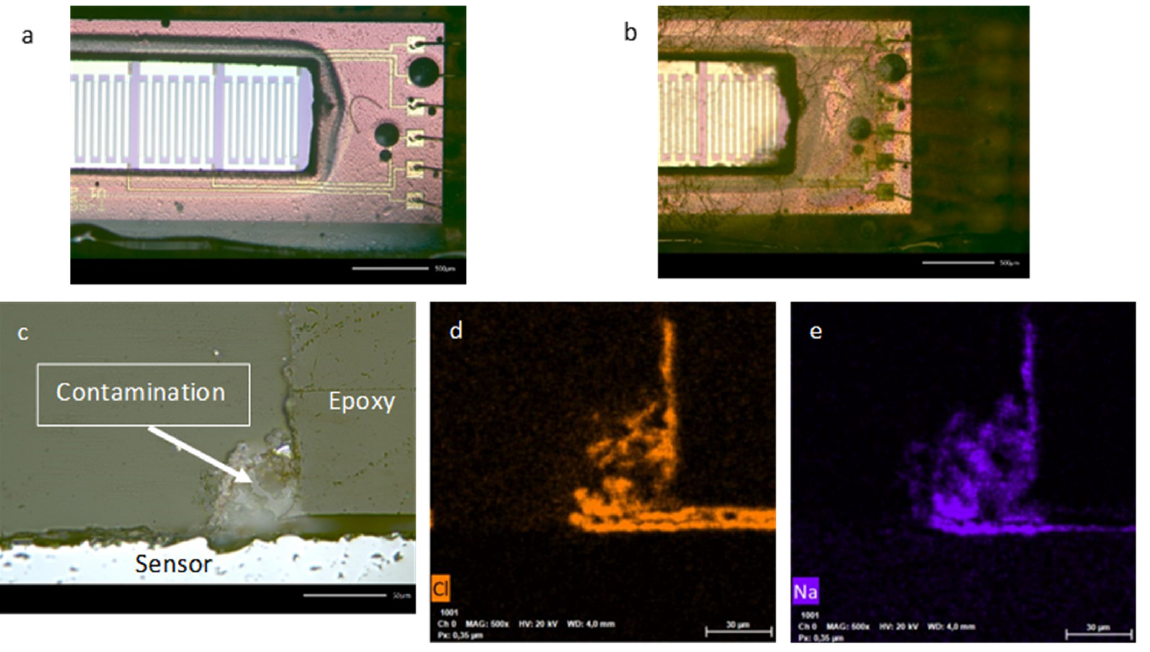
Figure 9. Failure analysis of the failed wire-bonded packages; ( a ) initial package, ( b ) failed package after 4th day of submergence in PBS solution, ( c ) cross-sectional optical image of the failed package and the degraded area, and ( d , e ) EDX images of the contaminated area in ( c ).